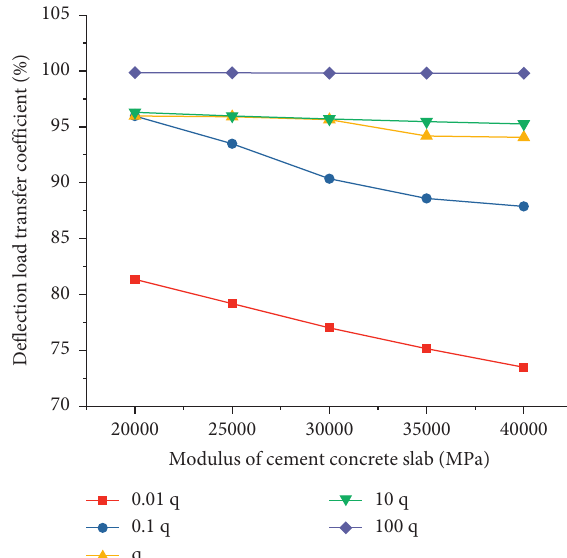
Figure 9: Variation of deflection load transfer coefficient with respect to the elastic modulus of cement concrete slab under different values of spring stiffness.